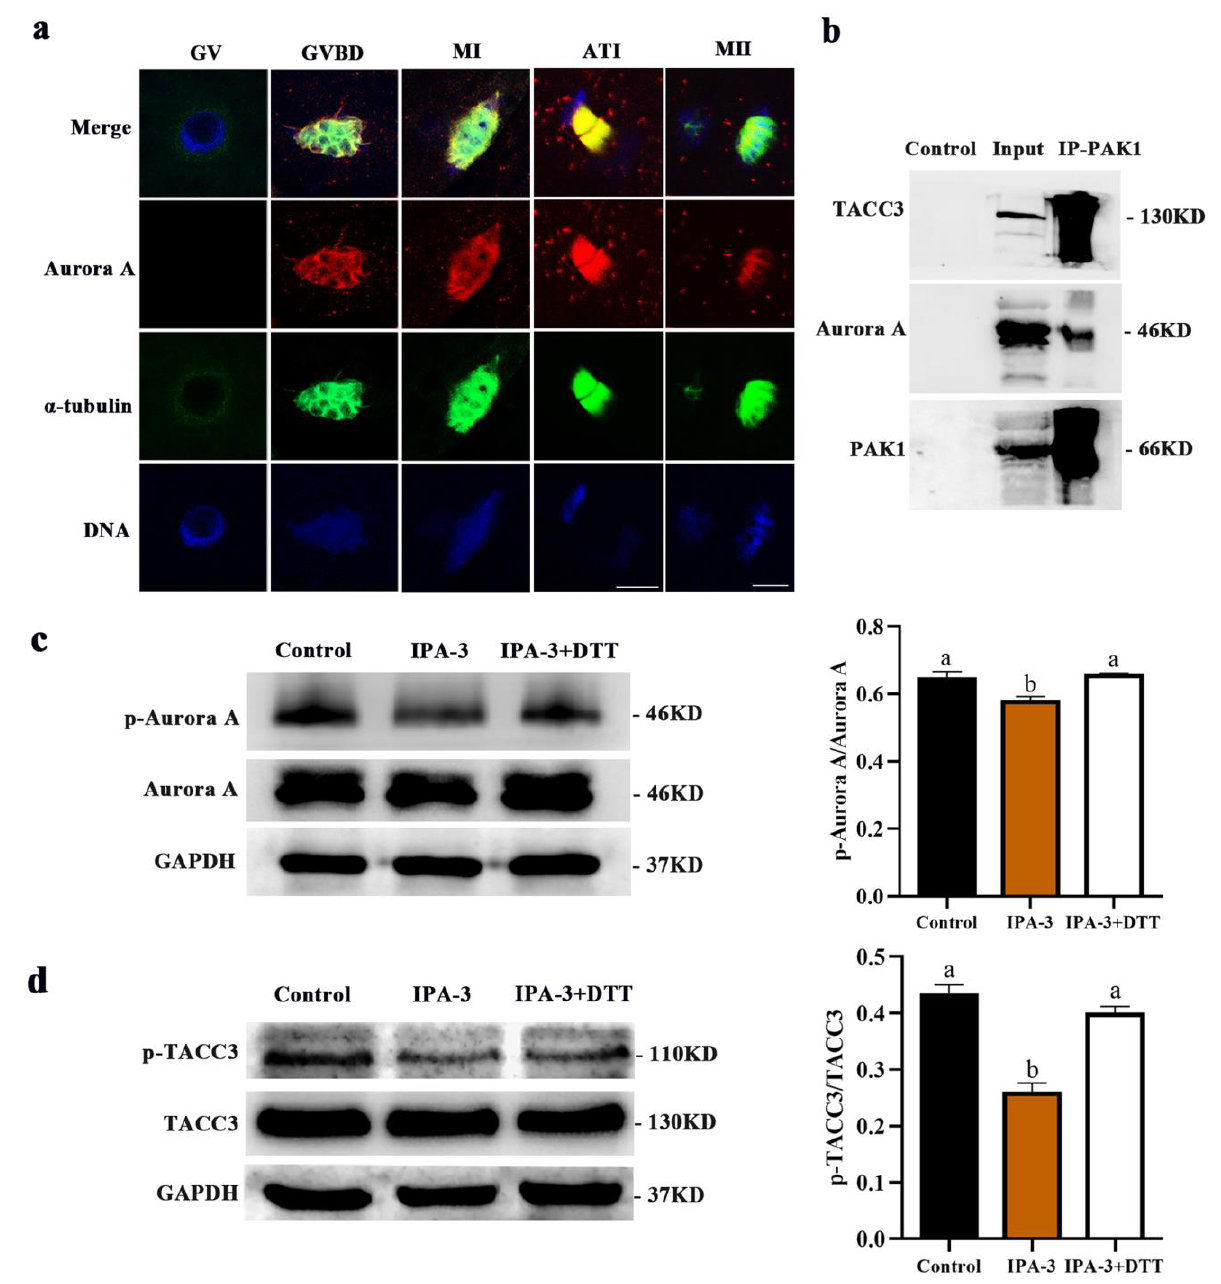
Figure 6. Effect of PAK1 inhibition on the expression of p-Aurora A and p-TACC3 during the first meiotic division (28 h). ( a ) Subcellular localization of Aurora A during meiosis in porcine oocytes ( n = 40). Red, Aurora A. Green, α -tubulin. Blue, chromosome. Scale bars are 10 µ m. ( b ) Co- immunoprecipitation results indicated that PAK1 was interacted with Aurora A and TACC3. ( c ) The expression of p-Aurora A in control, 30 µ M IPA-3 and IPA-3 + 1 mM DTT groups. ( d ) The expression of p-TACC3 in control, 30 µM IPA-3 and IPA-3 + 1 mM DTT groups. a, b Values with different superscript letters above columns indicate significant differences ( p < 0.05). GV, germinal vesicle; GVBD, germinal vesicle breakdown; MI, metaphase I; ATI, anaphase-telophase I; MII, metaphase II.